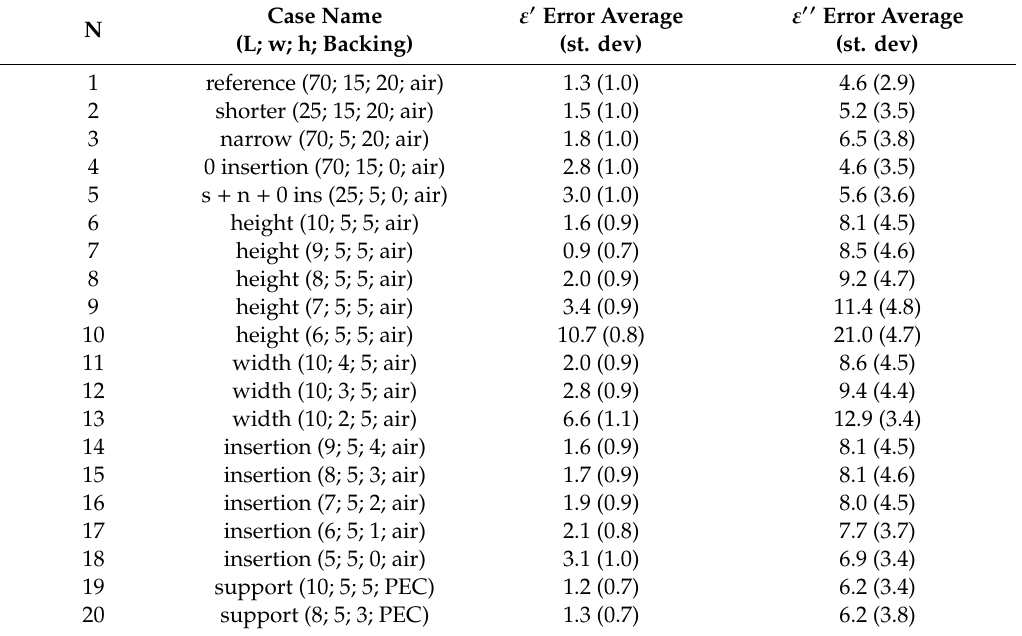
Table 3. Average errors achieved in the evaluation of the real and imaginary part of the relative complex permittivity of fat in several geometrical